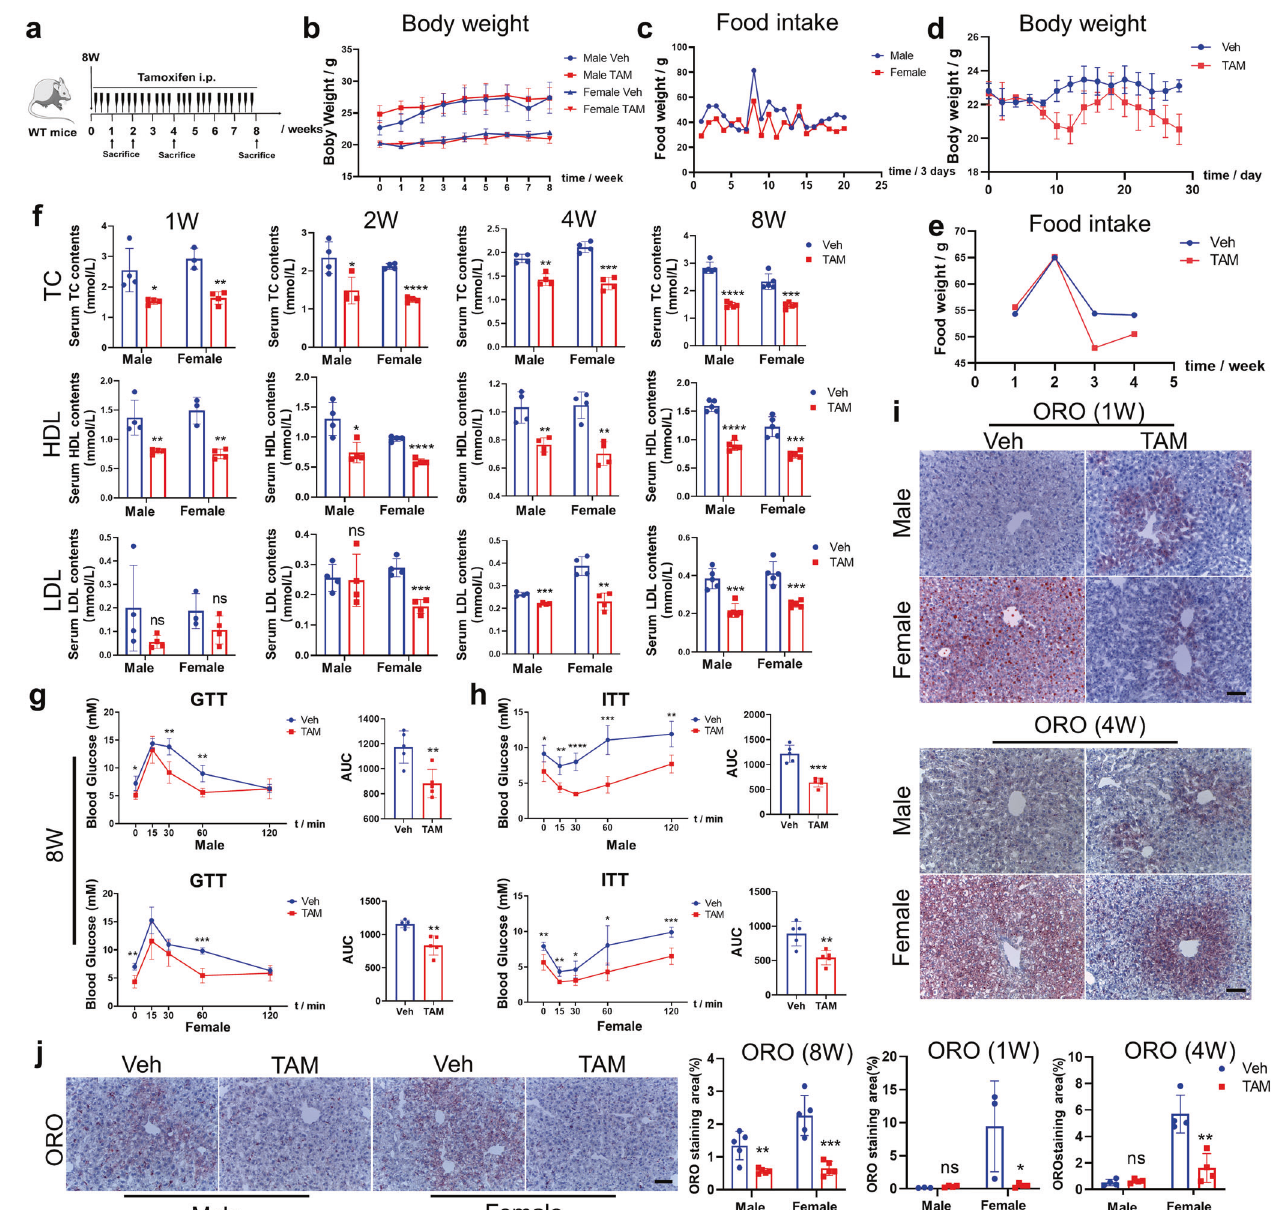
Fig. 2 Tamoxifen inhibited lipid accumulation in mice fed with normal diet. a Dosing scheme of tamoxifen on male and female C57BL/6 mice fed with normal diets. Dose of tamoxifen: 100 mg/kg. b Since initiating tamoxifen administration, mice were pair-fed and body weight was recorded weekly until mice were sacri fi ced. c Food consumption weight per cage was recorded when mice were administrated with tamoxifen. d Since initiating tamoxifen administration, mice were free-fed and body weight was recorded every other day for 4 weeks. e Food consumption weight per cage was recorded weekly when free-fed mice were administrated with tamoxifen. f Serum TC, HDL-C and LDL-C analysis of male and female mice fed with normal diets and administrated with vehicle/tamoxifen for 1, 2, 4, 8 weeks, respectively. g GTT test was performed on male and female mice administrated with tamoxifen or vehicle for 8 weeks and area under curve (AUC) was calculated and compared. h ITT test was performed on male and female mice administrated with tamoxifen or vehicle for 8 weeks and area under curve (AUC) was calculated and compared. i Frozen liver sections from male and female mice administrated with tamoxifen or vehicle for 1 and 4 weeks was performed ORO staining and ORO staining area was quantitatively compared. Scale bar:100 μ m. j Frozen liver sections from male and female mice administrated with tamoxifen or vehicle for 8 weeks were performed ORO staining and ORO staining area was quantitatively compared. Scale bar:100 μ m. Bars = means ± SD; n = 3 – 5; ns, no signi fi cance; * P < 0.05; ** P < 0.01; *** P < 0.001; **** P < 0.0001 Oral administration of tamoxifen effectively improves HFD- including Srebp1c, CD36, SCD1, FASN, ACC1, and PPAR γ , was induced NAFLD neutralized by using tamoxifen (Fig. 4g). To recon fi rm the Considering that tamoxifen is usually delivered orally in clinical molecular changes in tamoxifen-treated liver, CD36, SCD1, CCL2, practice, we investigated whether oral tamoxifen administration CXCL10, Col3a1, and Timp1 were measured by RT-qPCR in total alleviated NAFLD in HFD-induced NAFLD mice. NAFLD mice were liver tissue and all of them were downregulated by tamoxifen administrated with 100 mg/kg tamoxifen or vehicle by oral (Supplementary Fig. S4c).